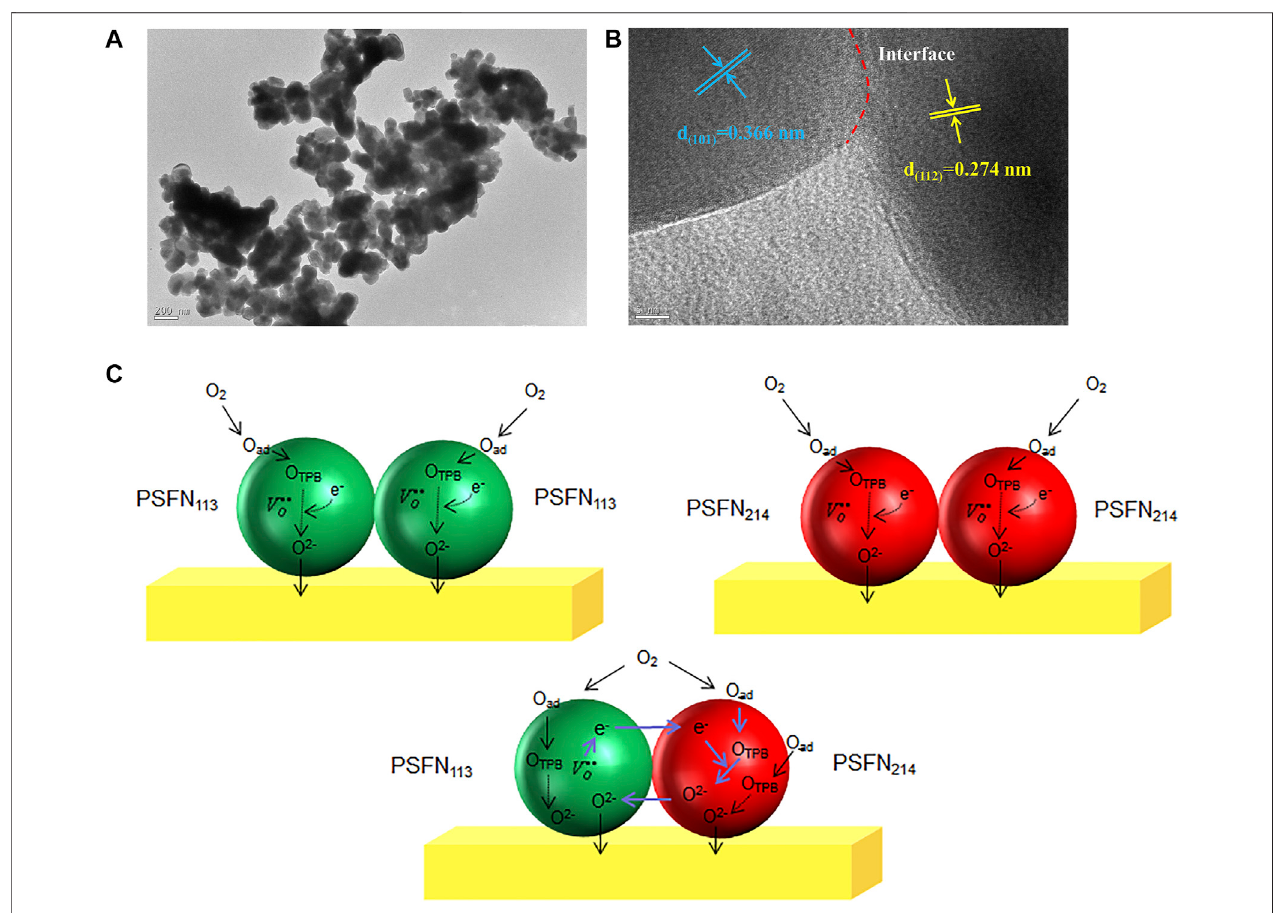
FIGURE 5 | (A) TEM image, (B) HR-TEM image, and (C) performance improvement mechanism diagram of PSFN 113-214 (5:5) heterocomposite cathode.